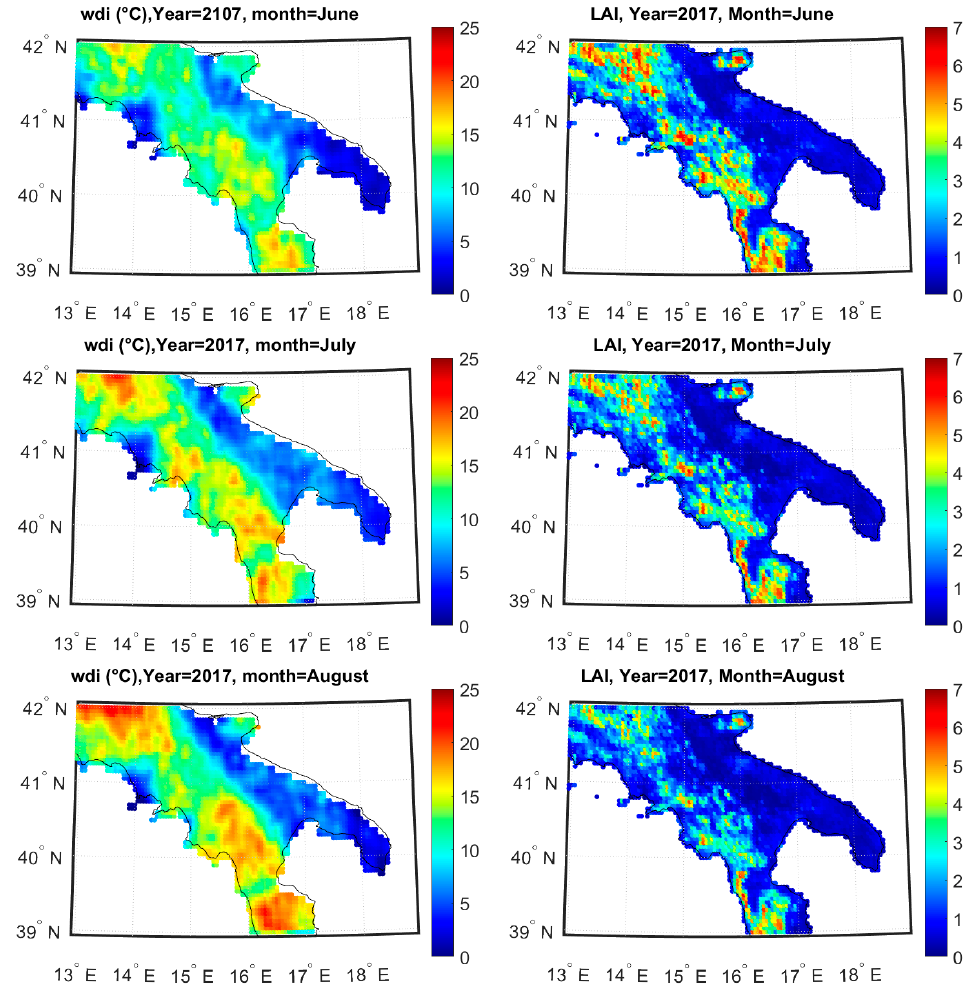
Figure 9. Comparison of LAI (m 2 /m 2 ) vs. wdi for the period of June to August in 2017. Top to bottom, June to August.